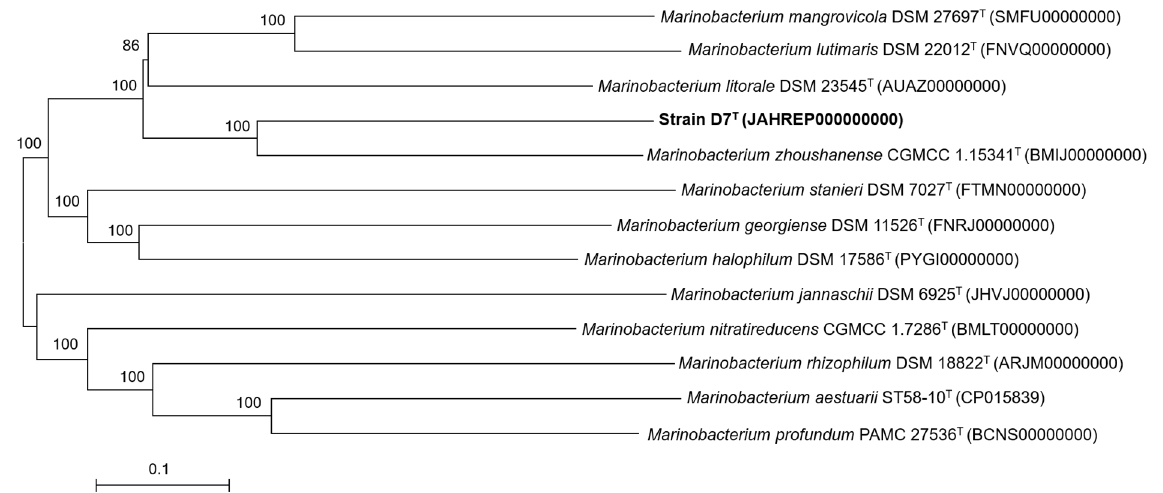
Figure 3. Neighbor-joining core gene phylogenetic tree including available genomes of the genus Marinobacterium and strain D7 T . The tree was recovered from the alignment of 134 single-copy orthologous translated genes shared between these genomes. Bar, 0.1 substitutions per amino acid